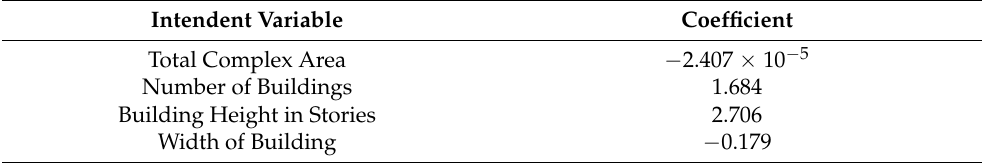
Table 8. Regression Coeffients for Cost